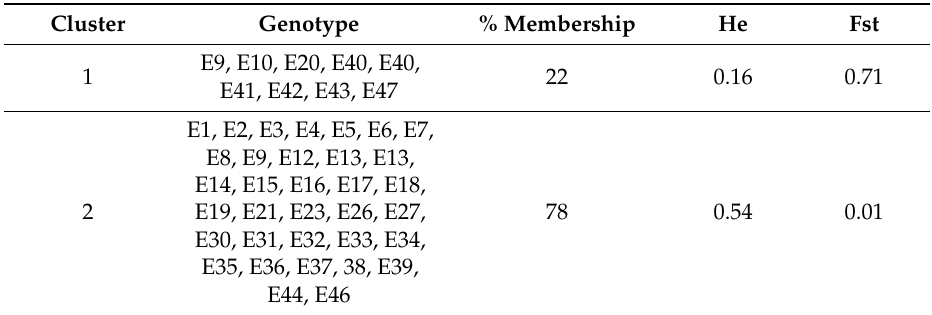
Figure 1. Population structure of 48 accessions based on 35 SSR markers (K = 2) and graph of estimated membership fraction for K = 2. The maximum of ad hoc measure ∆ K determined by structure harvester was found to be K = 2, which indicated that the four populations can be grouped into two subgroups. Table 5. Genetic clusters and member of genotypes observed from population structure analysis of 48 pigeonpea